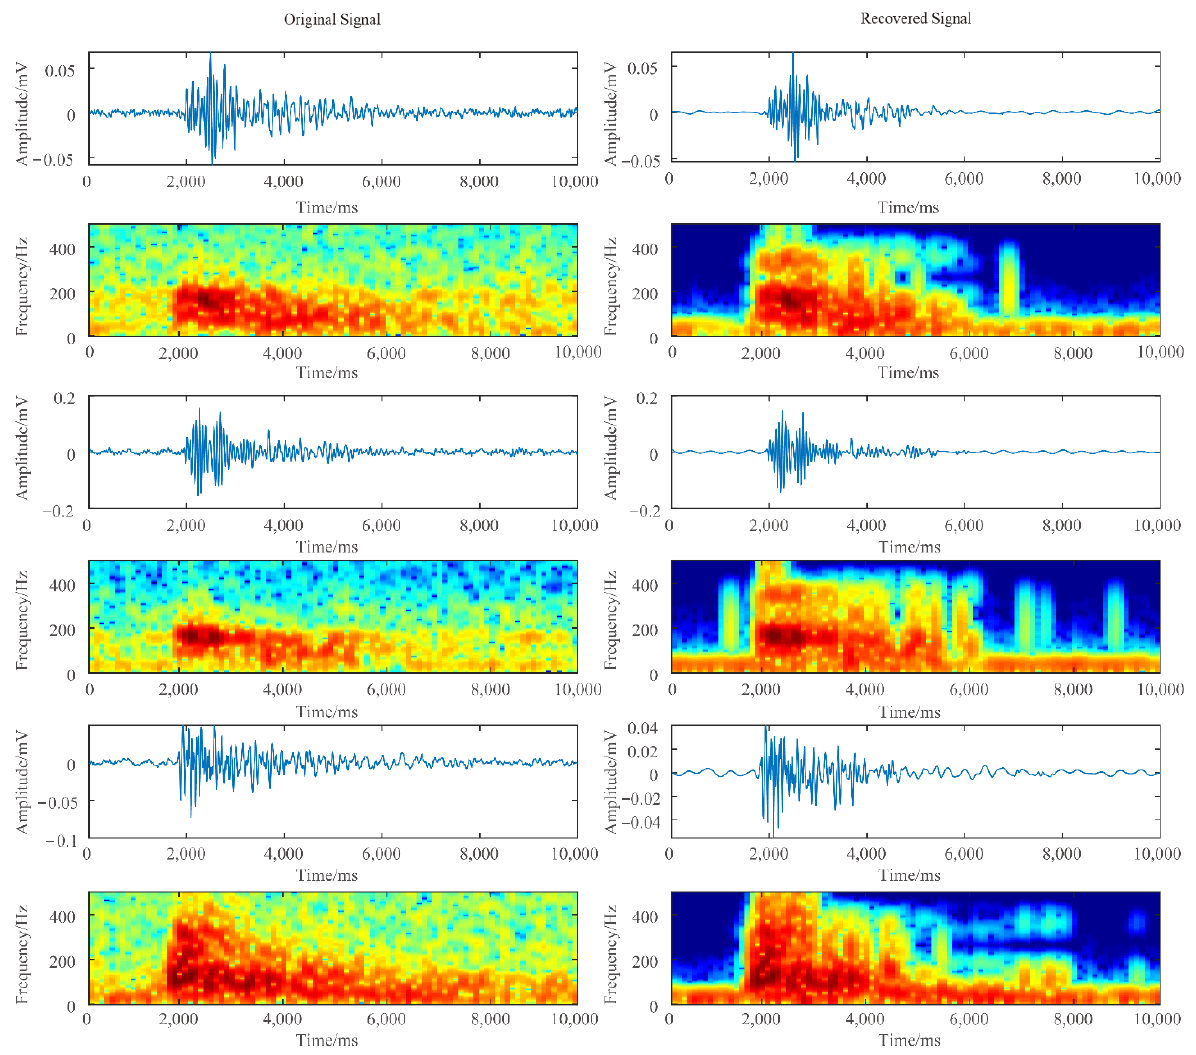
Figure 5. Original MS signals, recovered MS signals, and their time-frequency spectra.